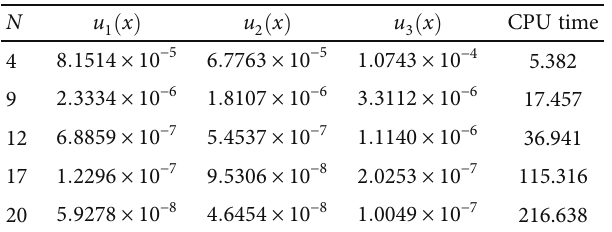
Figure 3: Some illustrations for the exact and approximate solutions using di ff erent values of ν Table 2: Maximum absolute errors for di ff erent values of N for Example 2.